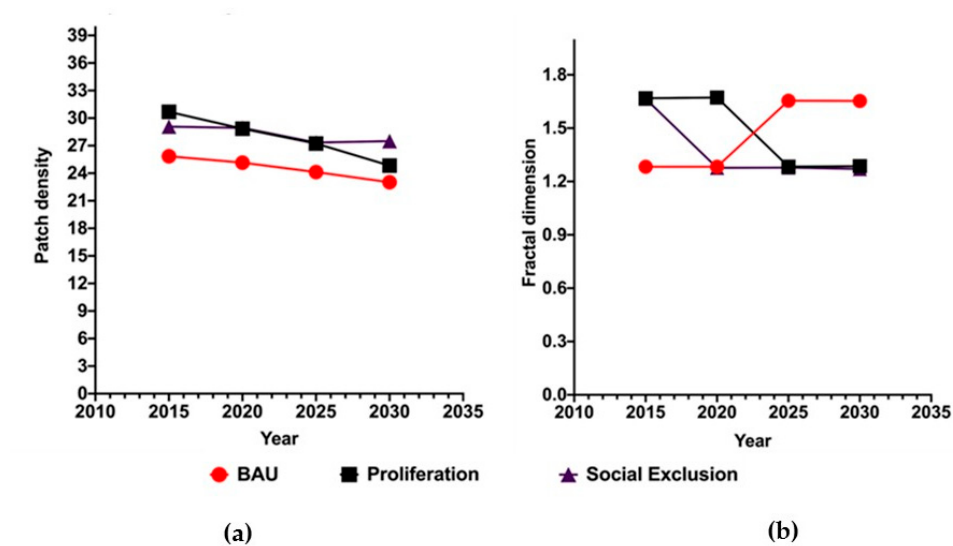
Figure 6. Characterisation of the Cape Town landscape using; ( a ) patch density; ( b ) fractal dimension .